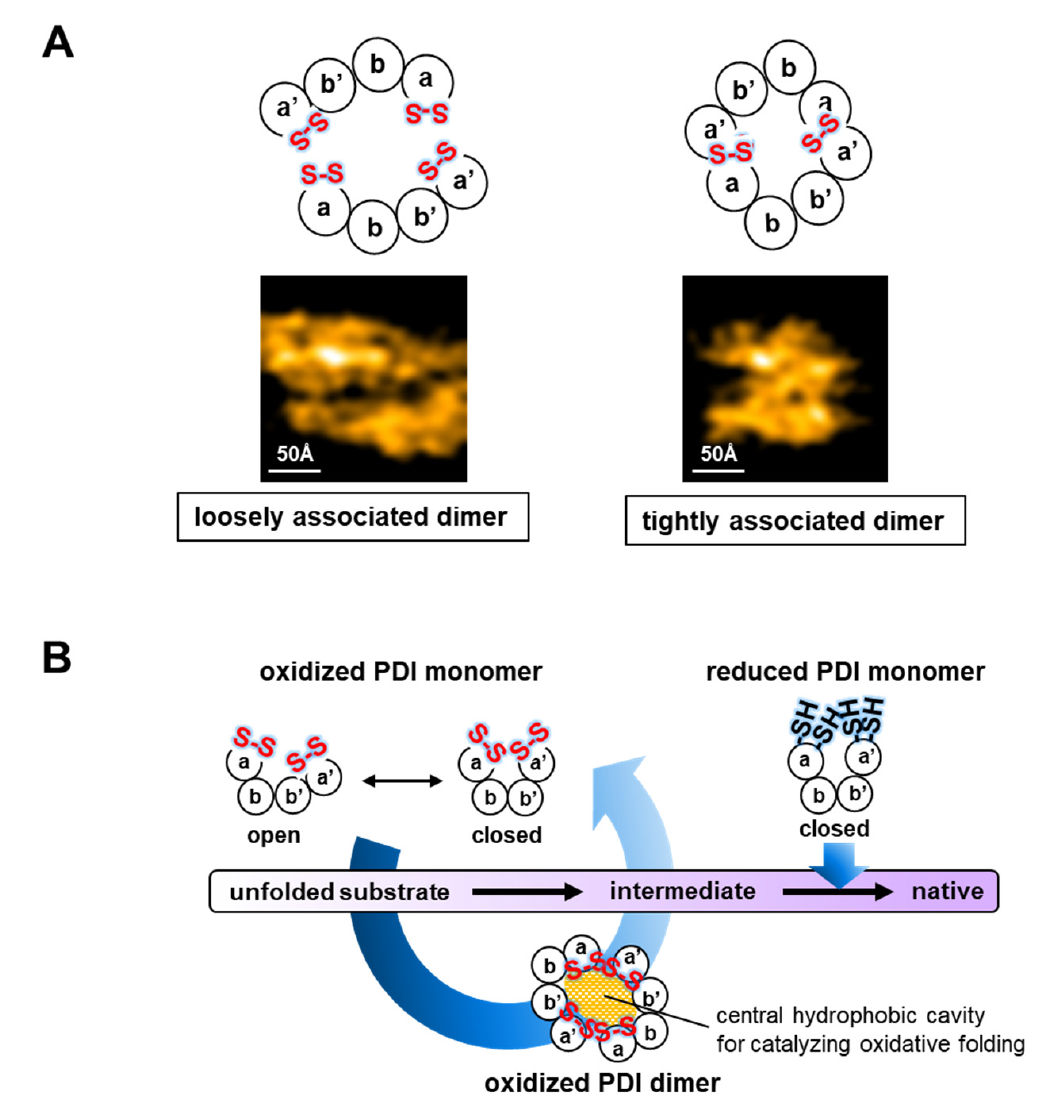
Figure 2. The dimeric PDI-mediated oxidative protein folding process. ( A ) Schematic structures (upper) and HS-AFM images (lower; scan area 200 × 200 Å 2 ; scale bar 50 Å) of loosely (left) and tightly associated dimers (right) of human PDI. ( B ) Schematic diagram of redox-dependent conformational changes and substrate-induced PDI dimerization during the catalysis of oxidative protein folding.